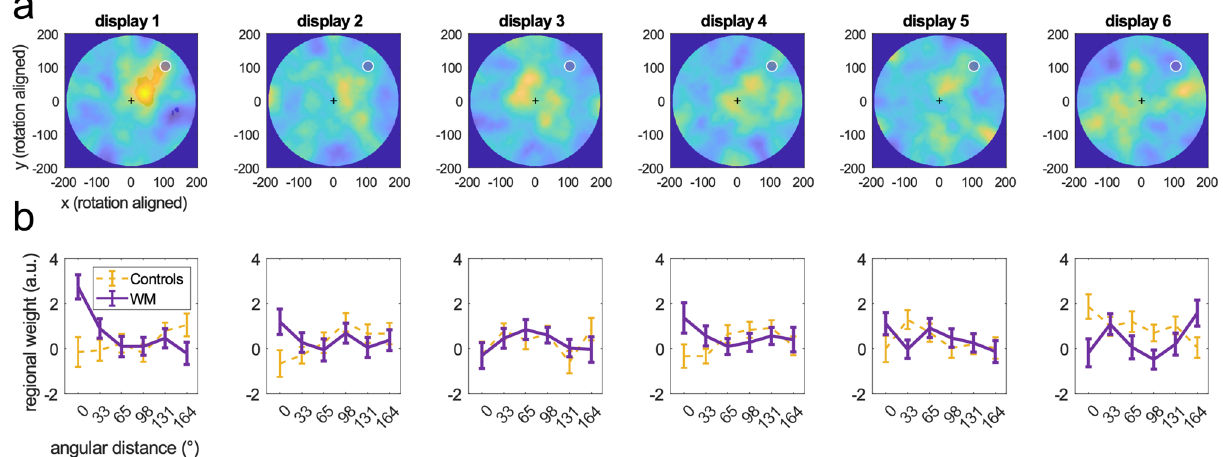
Figure 3. Regional weight concentration—time course. ( a ) spatial weighting on WM trials after rotational alignment as in Fig. 2c but shown separately for each of the six displays in the decision stream. A significant regional gain concentration ( p < 0.05, two-tailed, FDR-corrected, indicated by transparent mask) was observed in display 1 only. ( b ) Purple: angular tuning of spatial weighting in terms of mean angular distance from the WM sample (cf. Fig. 2d). Significant tuning was evident exclusively in display 1. Yellow curves show analogue analysis of control trials (pooled over control conditions 1 & 2) pseudo-aligned to the same WM-locations as the